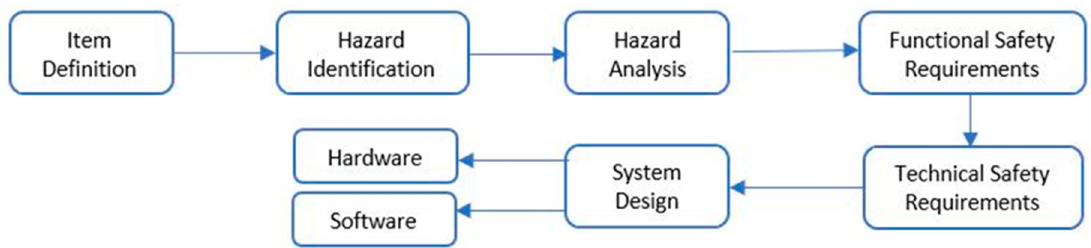
Figure 14. Functional safety process diagram.